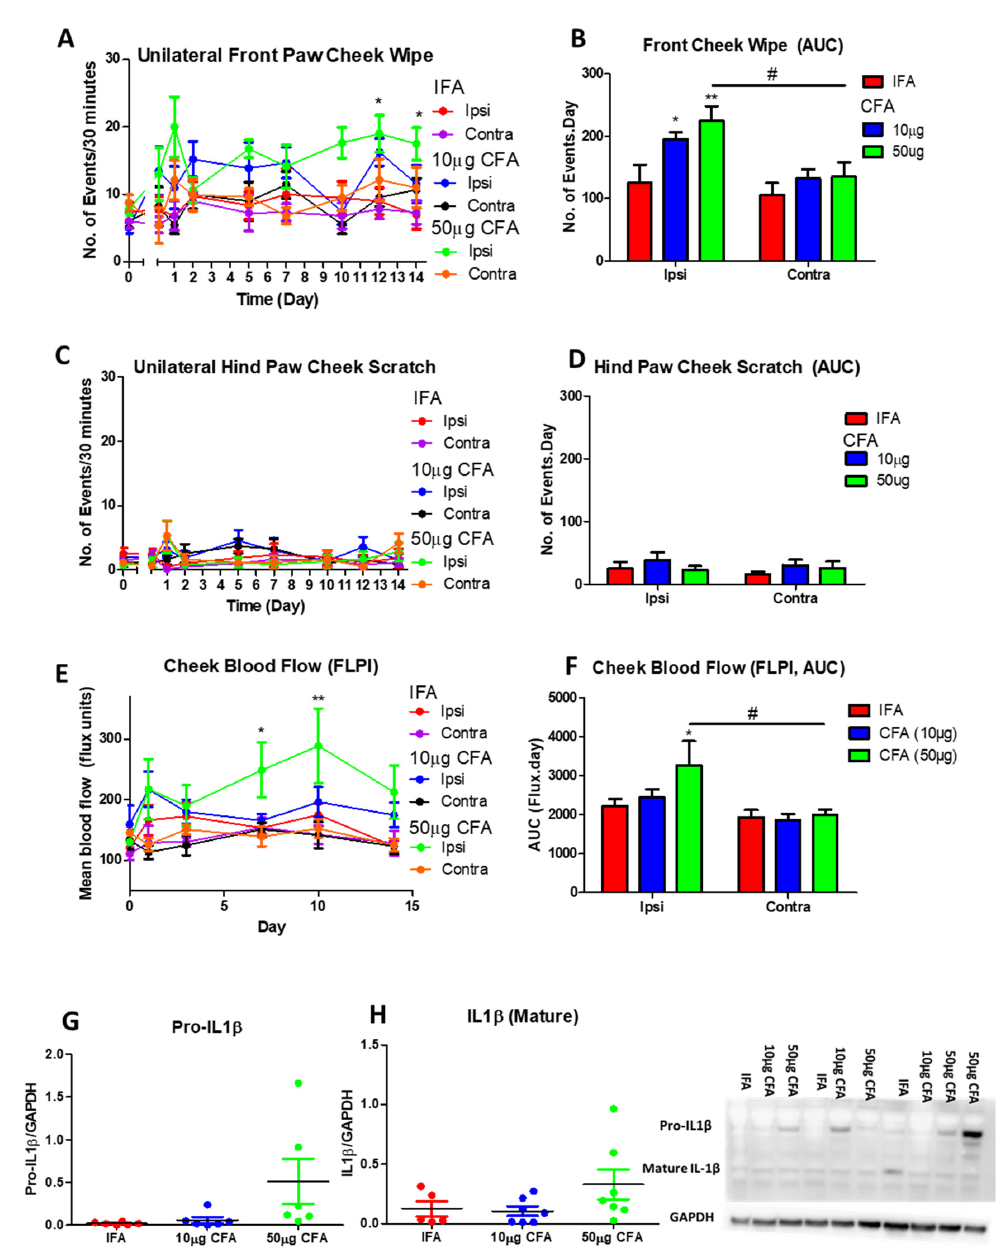
Figure 3. Fifty µg CFA injection i.a. into the TMJ resulted in a significant, consistent increase in pain-like spontaneous behaviours and cheek blood flow over 14 days. The numbers of ( A ) unilateral front paw cheek wipe and ( C ) unilateral hind paw cheek scratch observed over 30 min. AUC for the ( B ) front paw cheek wipe and ( D ) hind paw cheek scratch calculated over the 14 days. ( E ) Cheek blood flow measured using the FLPI and ( F ) AUC of the cheek blood flow calculated over 14 days, ( G ) ProIL-1 β and ( H ) mature IL-1 β Western blots on TMJ samples. Data represent mean ± SEM, n = 6 − 7 animals per group. Data analysed by two-way ANOVA (repeated measures for figures ( A , C , E ) with Bonferroni’s post hoc test. * p < 0.05, ** p < 0.01 between IFA and CFA, # p < 0.05 between ipsi vs. contra.